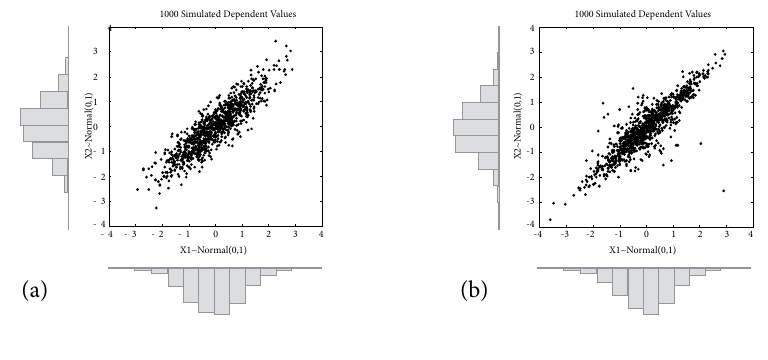
Fig. 2. Different dependency structures between X 1 and X 2 with ρ =